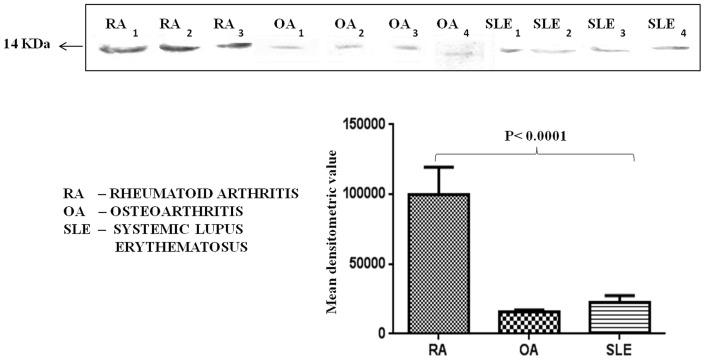
Expression of TTR in RA, Osteoarthritis and Systemic lupus erythematosus patients.TTR expressions were examined in other joint disease and autoimmune disease such as OA and SLE. Western blot analysis showed that TTR level was significantly down regulated (p<0.0001) in the plasma of OA and SLE patients as compared to the RA patients. Densitometric analysis indicated 6.6 and 5 fold higher expression of TTR in RA (n = 9) as compared to OA (n = 12) and SLE (n = 12) respectively.